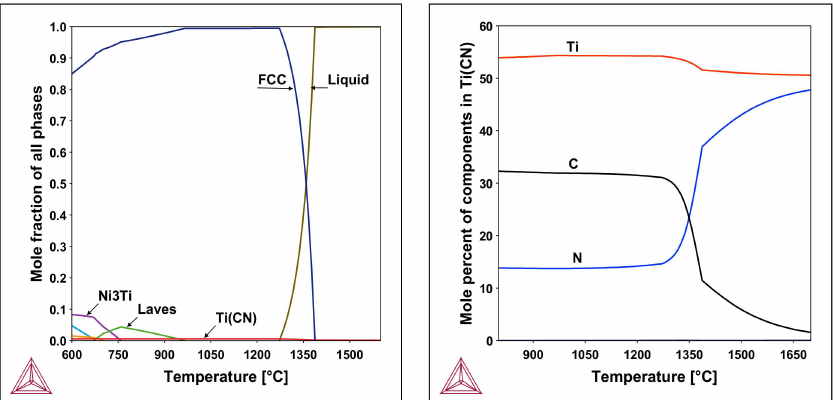
Figure 19. Equilibrium phases and composition of the Ti(CN) phase as calculated with Thermo-Calc, database